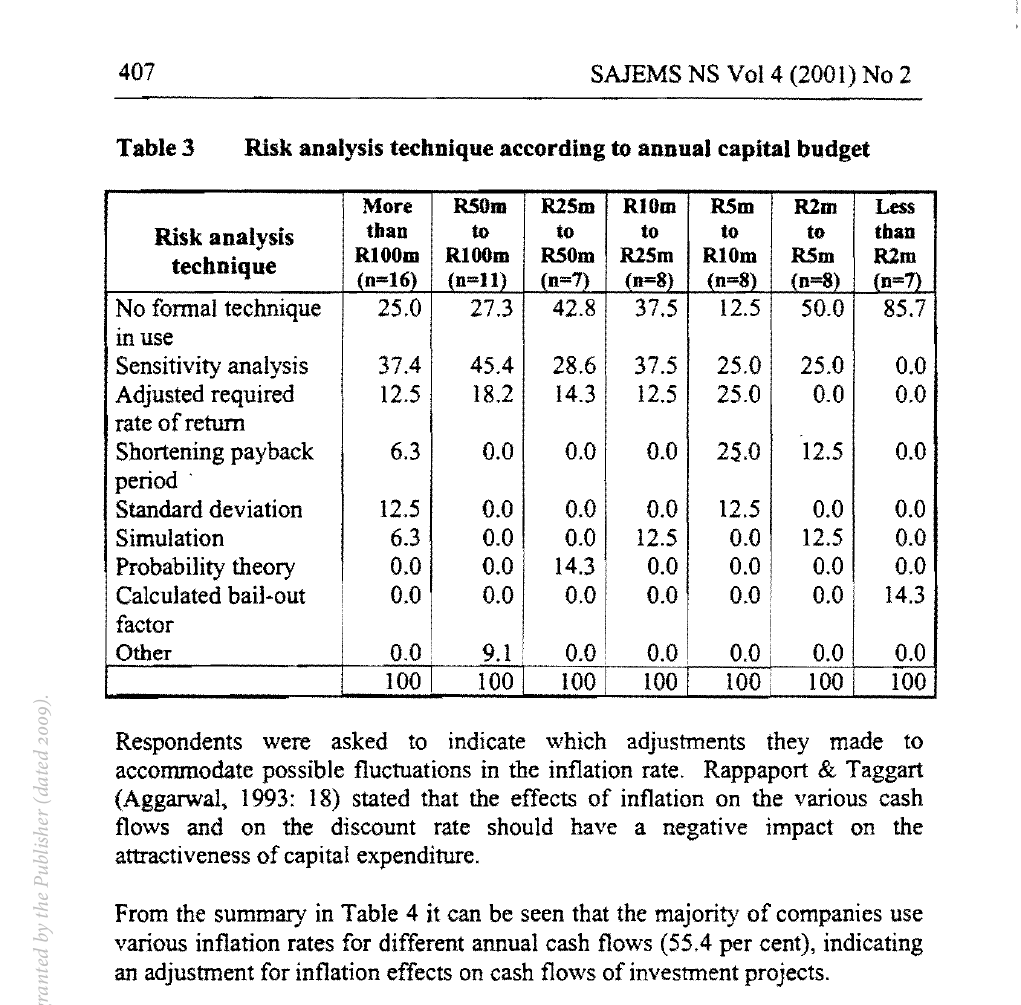
Risk analysis technique according to annual capital